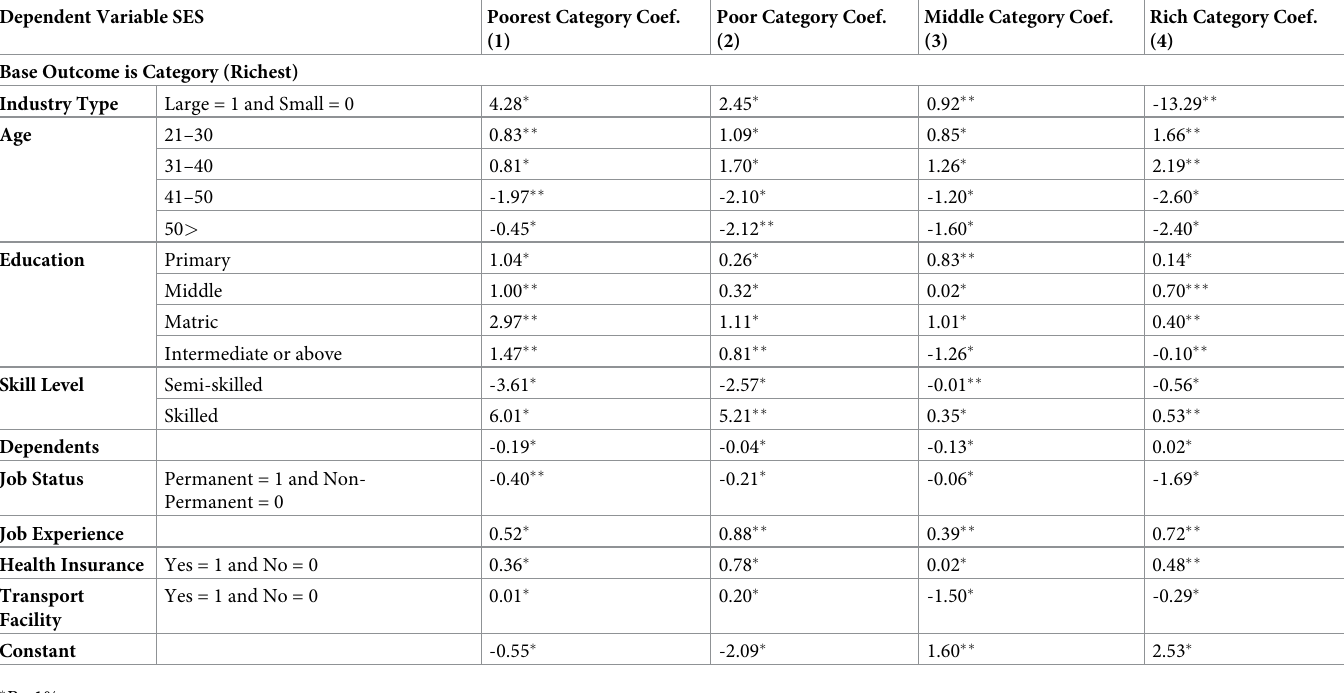
Table 3. Empirical